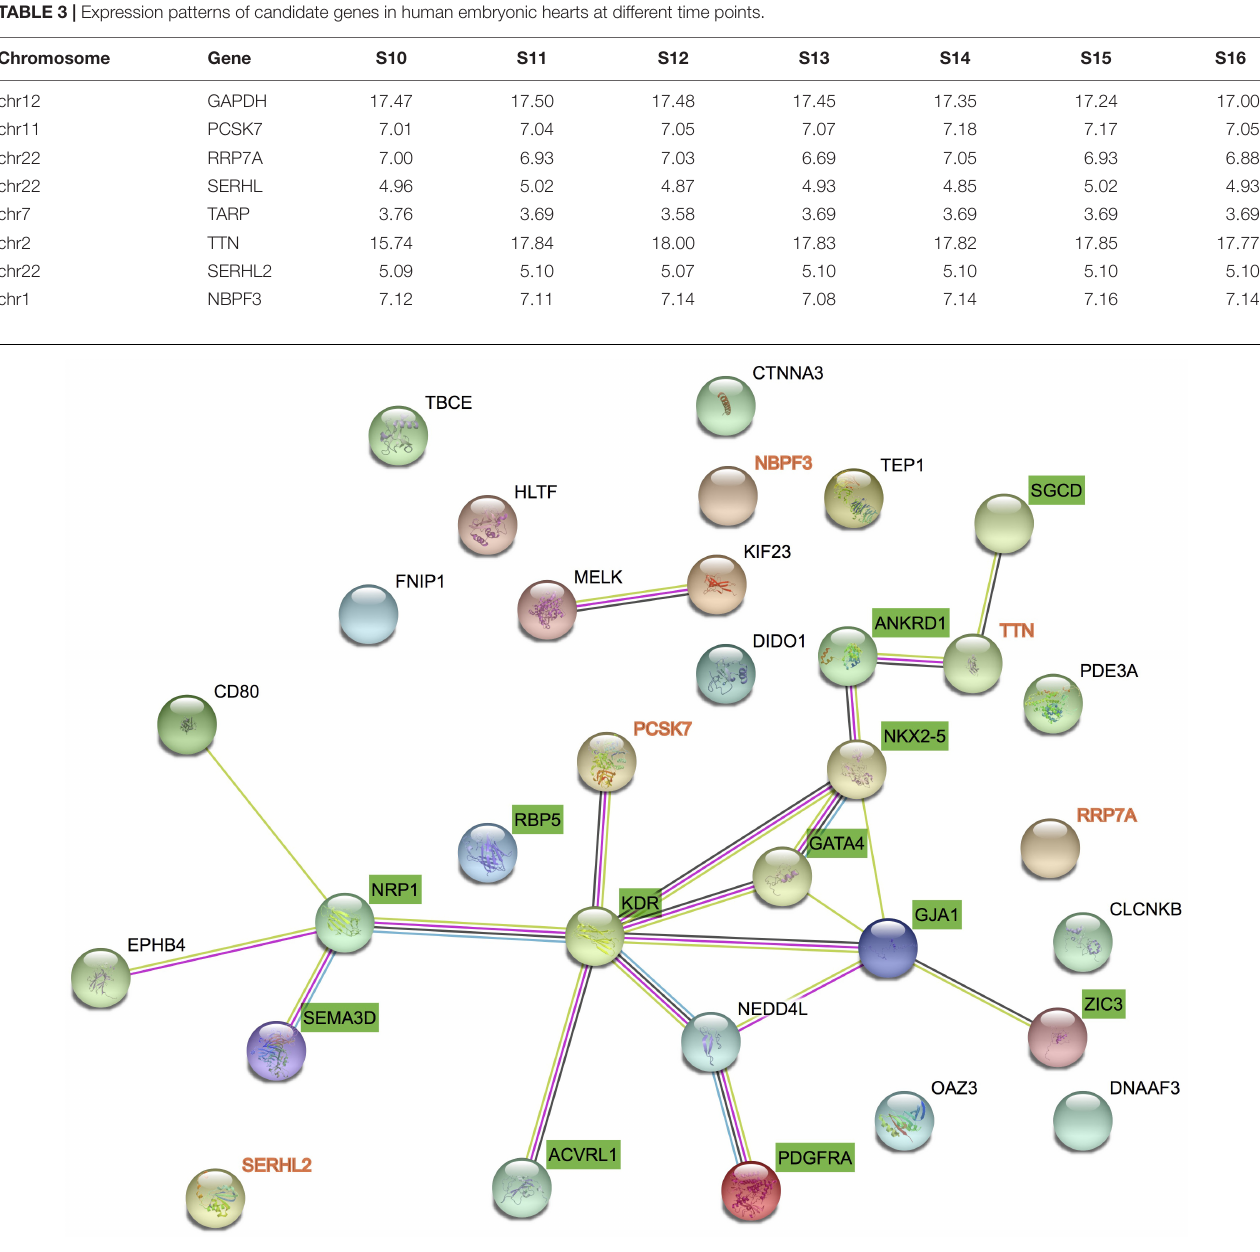
FIGURE 3 | Protein–protein interaction between candidate genes and known genes. STRING networks included 27 genes previously associated to TAPVC and 7 candidate genes highlighted by CNV detection analysis.